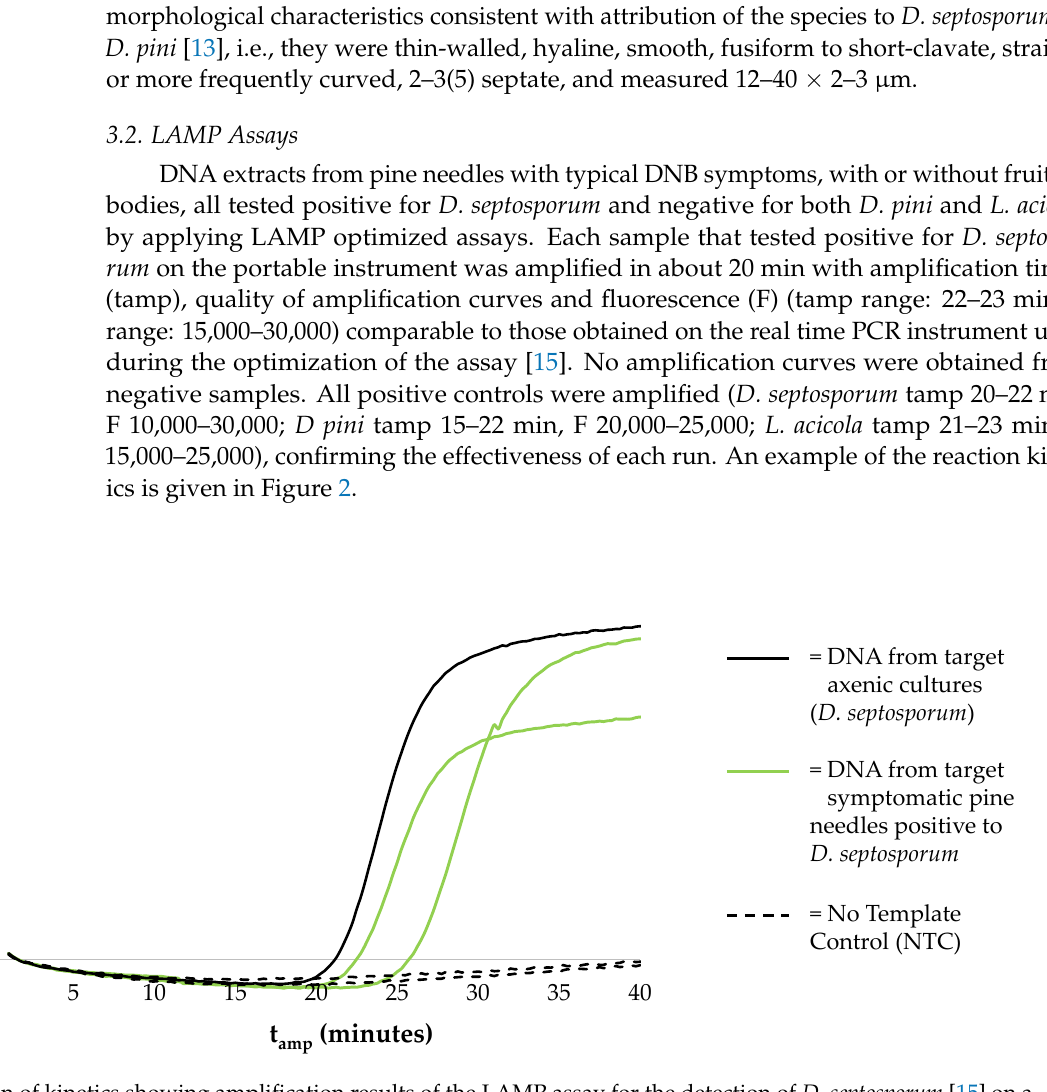
Figure 2. Selection of kinetics showing amplification results of the LAMP assay for the detection of D. septosporum [15] on a portable instrument (Genie III OptiGene, Limited, Horsham,